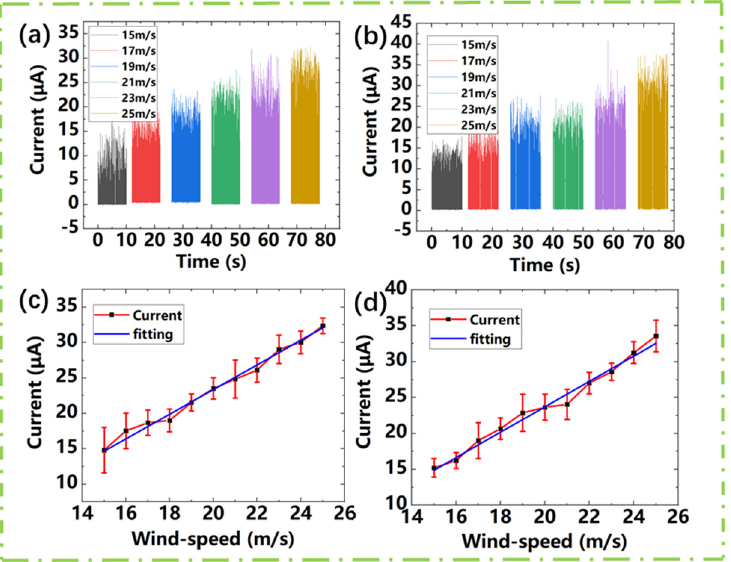
Figure 3. Wind-TENG output curve changes under the wind speed from 15 m/s to 25 m/s. ( a ) TENG1 rectified short-circuit current. ( b ) TENG2 rectified short-circuit current. ( c ) TENG1 rectified short-circuit current changes with wind speed. ( d ) TENG2 rectified short-circuit current changes with wind speed.